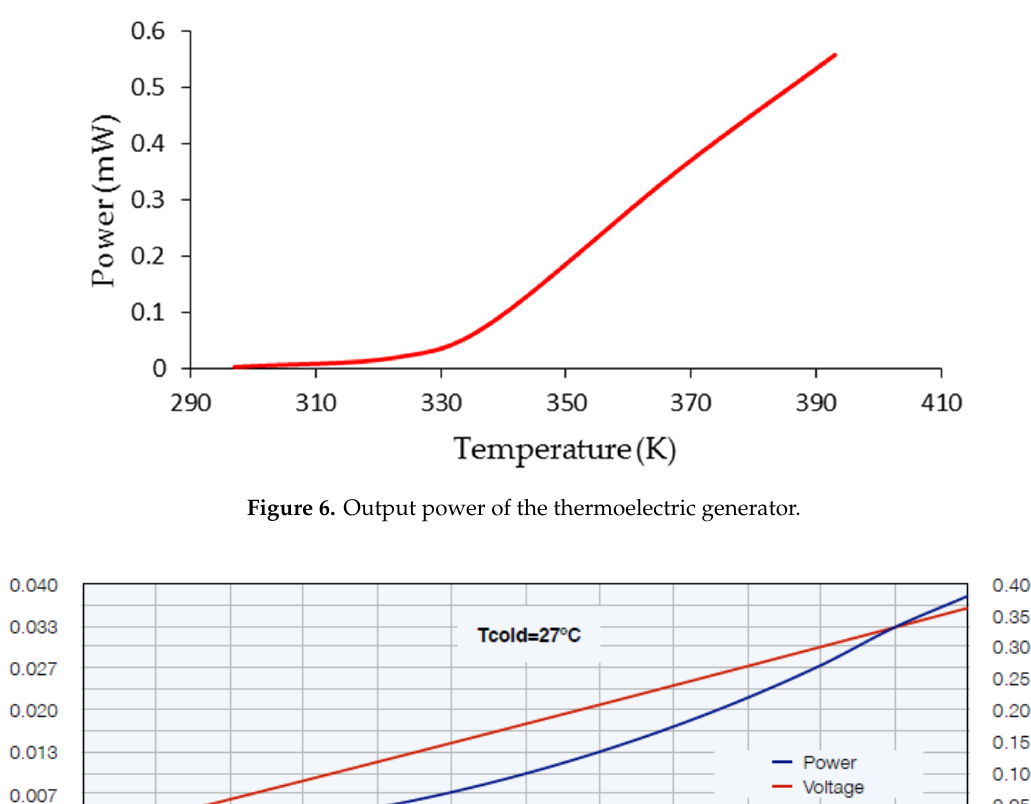
Figure 7. Voltage and power output for commercial thermoelectric generator 1MD03-024-04/1.